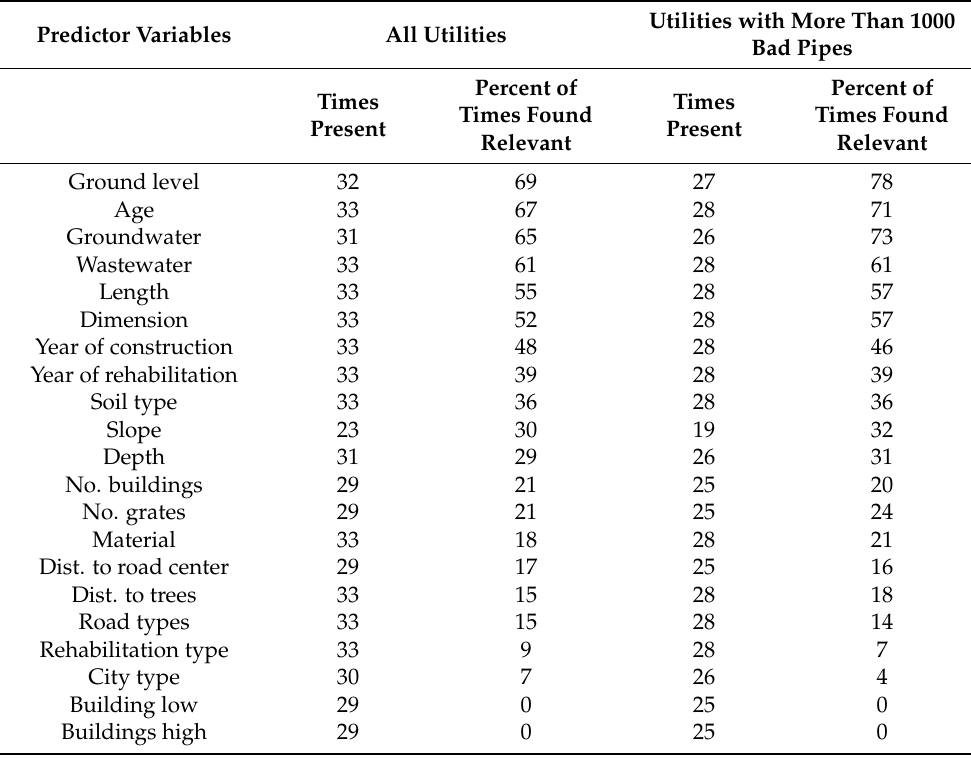
Table 5. Overview of how often a feature contributes to the performance when considering all the utilities and when considering only utilities with more than 1000 bad